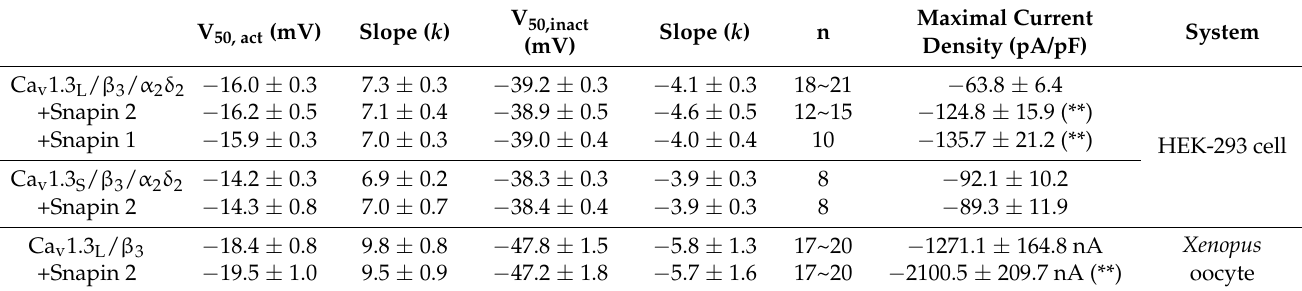
Table 1. Summary of biophysical properties of Ca v 1.3 channels co-expressed with